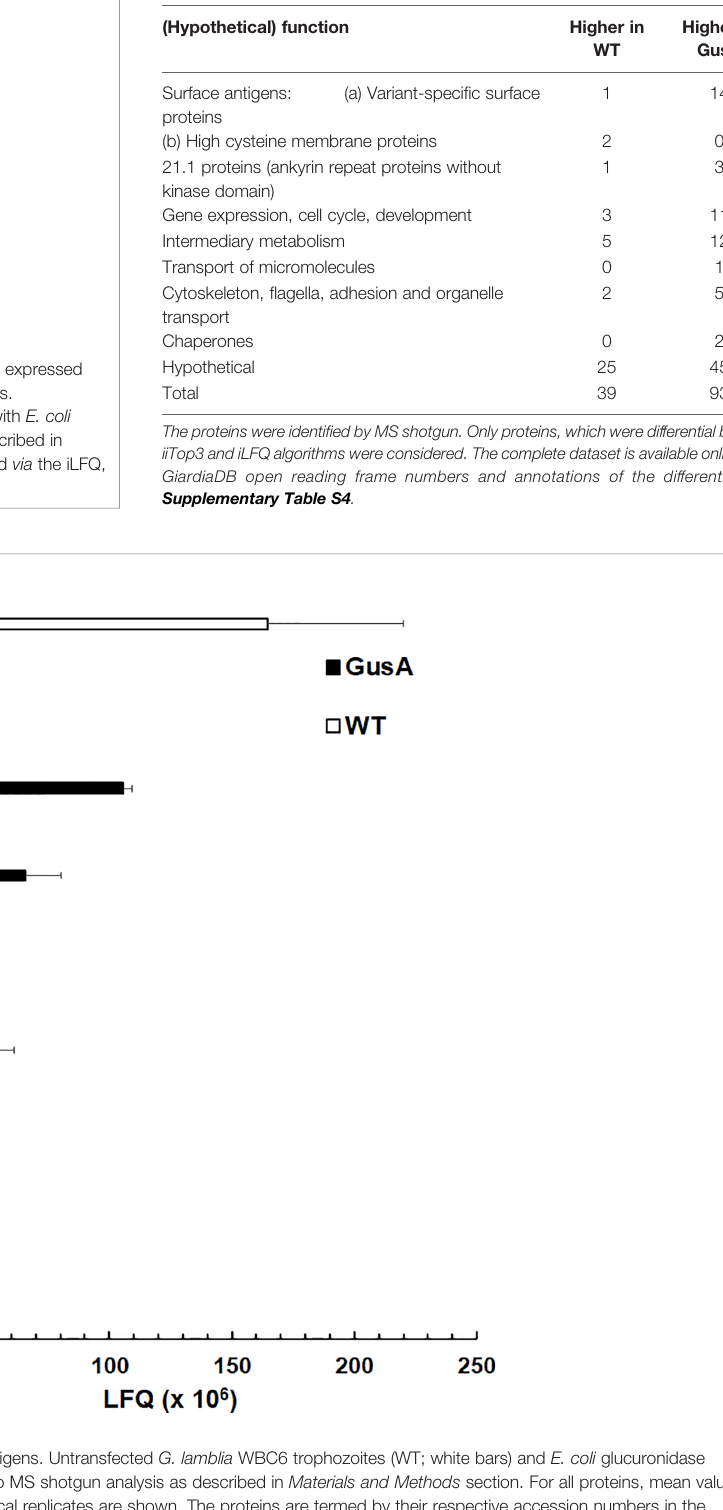
TABLE 2 | Overview of differentially expressed proteins in untransfected G. lamblia wildtype (WT) and E. coli glucuronidase A-transfected trophozoites (GusA).